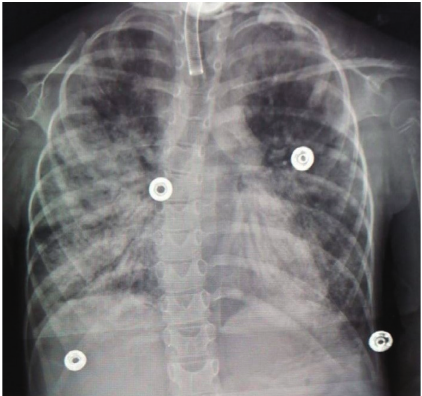
Figure 3: Day 7 of COVID-19: “whiteout” of the lungs bilaterally consistent with established acute respiratory distress syndrome